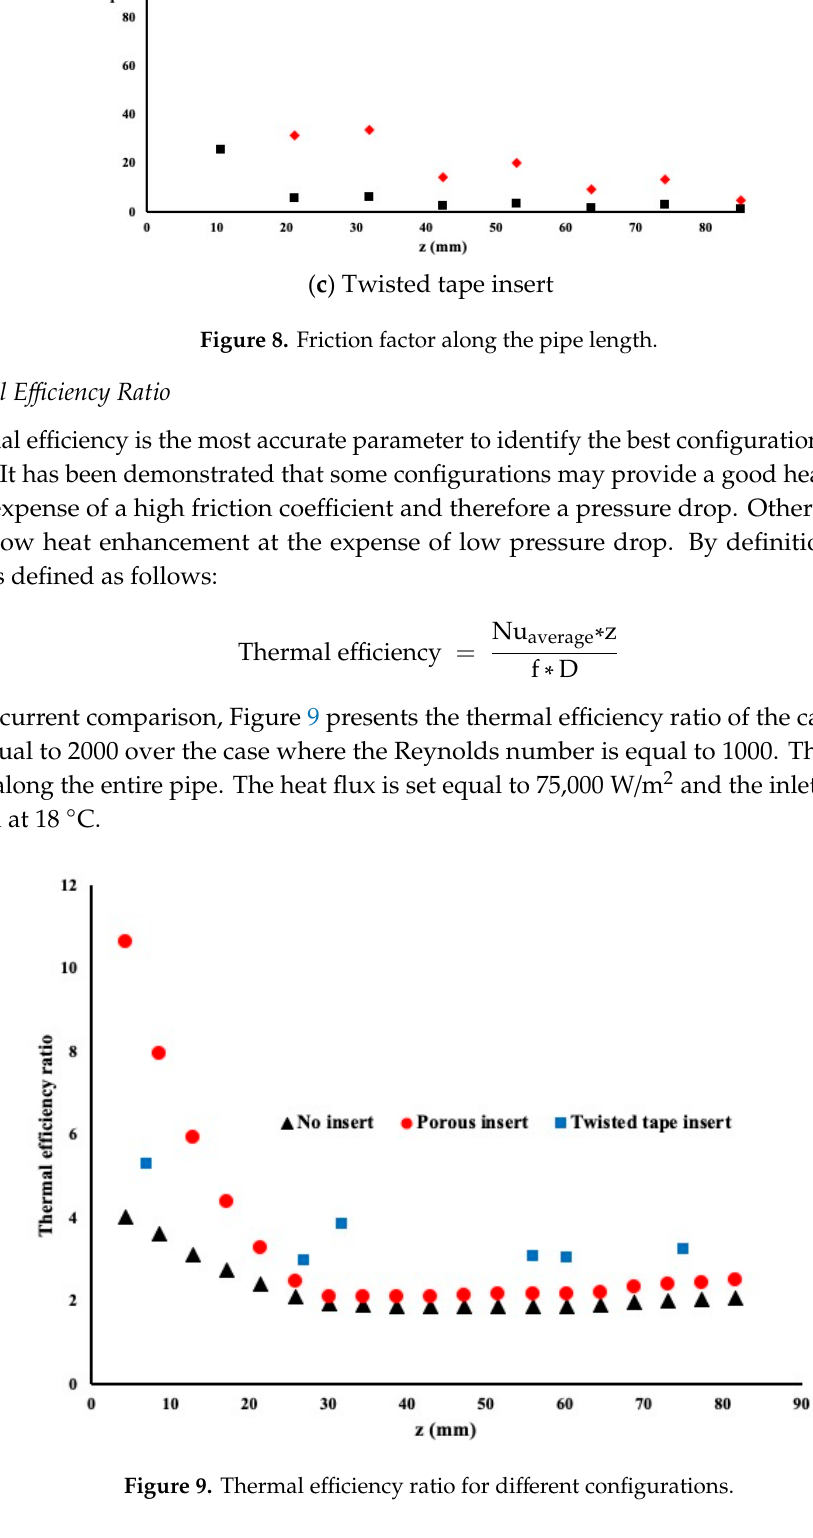
Figure 8. Friction factor along the pipe length.